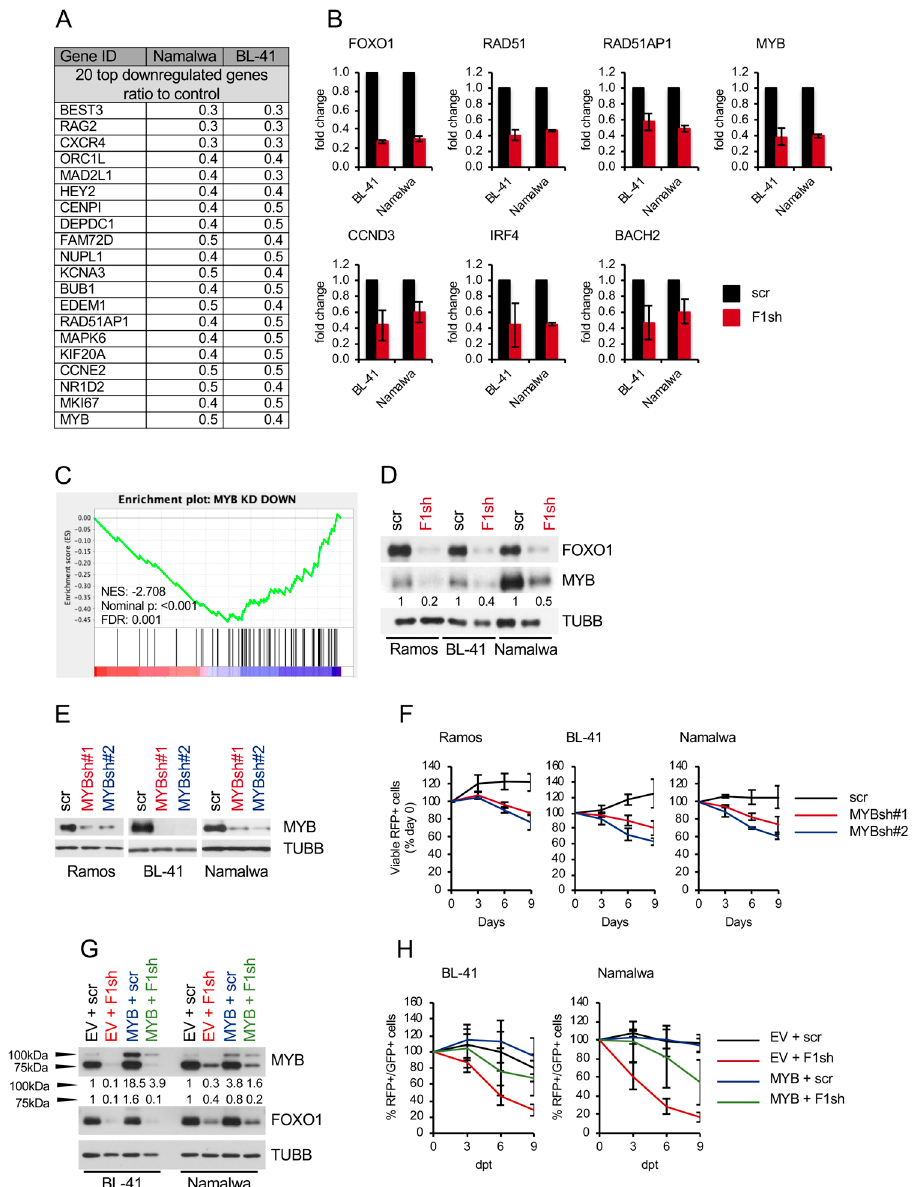
Figure 2. Mechanism of the anti-tumor e ff ect of FOXO1 knockdown. ( A ) Top 20 genes downregulated after FOXO1 knockdown > 1.5-fold in both cell lines. BL cell lines expressing F1sh or scr control were harvested on day 4 after transduction for gene expression profiling using Human Gene 1.0 ST A ff ymetrix GeneChiparray. AnalysisofrawdatawasdoneusingGenesiftersoftware(RMAnormalization, centered Pearson correlation, coe ffi cient 0.98) ( n = 2). ( B ) Validation of the GEP. The e ff ect of FOXO1 knockdown on the expression of indicated genes was validated by qRT-PCR. qRT-PCR data were quantified by the 2 − ∆∆ CT method. Data are shown as mean ± SD ( n = 2). The data were analyzed by two-sided T-test. For all genes and cell lines p < 0.05. ( C ) GSEA. MYB depletion signature is repressed by FOXO1 knockdown (Table S12). Direction of phenotype comparison: “F1sh vs. scr”. Gene signature “MYB KD DOWN” [27] comprises genes downregulated by MYB knockdown with p < 0.05 (Table S18) and was applied on set of genes modulated more than 1.5-fold by FOXO1 knockdown (threshold of 1.5, ANOVA, Benjamini and Hochberg correction, adjusted p < 0.05). NES: Normalized enrichment score. FDR: False discovery rate. ( D ) BL cells transduced with F1sh and scr vectors were selected for 2 days using 4 µ g / mL puromycin, and MYB expression was analyzed by immunoblot. TUBB served as loading control. A representative of 2 independent experiments is shown. Densitometric quantification of MYB